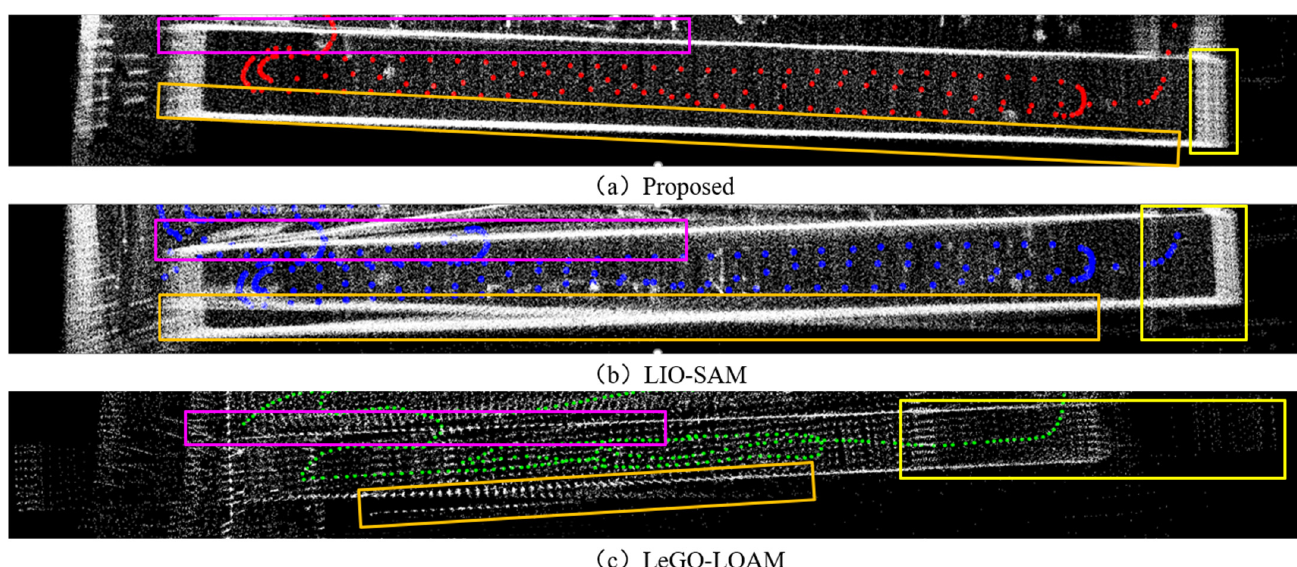
Figure 10. Trajectories and mapping results by the proposed method and other methods in the preparation roadway. ( a – c ) Trajectories and mapping results by the proposed method, LIO-SAM and LeGO-LOAM, respectively.